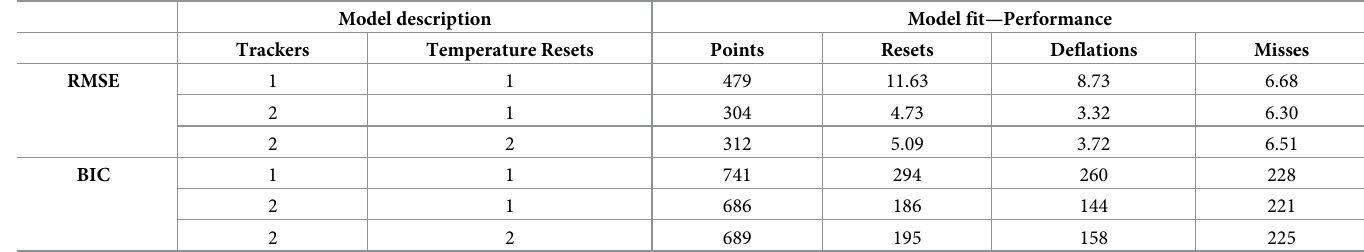
Table 3. Goodness of fit in terms of RMSE and BIC and model comparison across performance